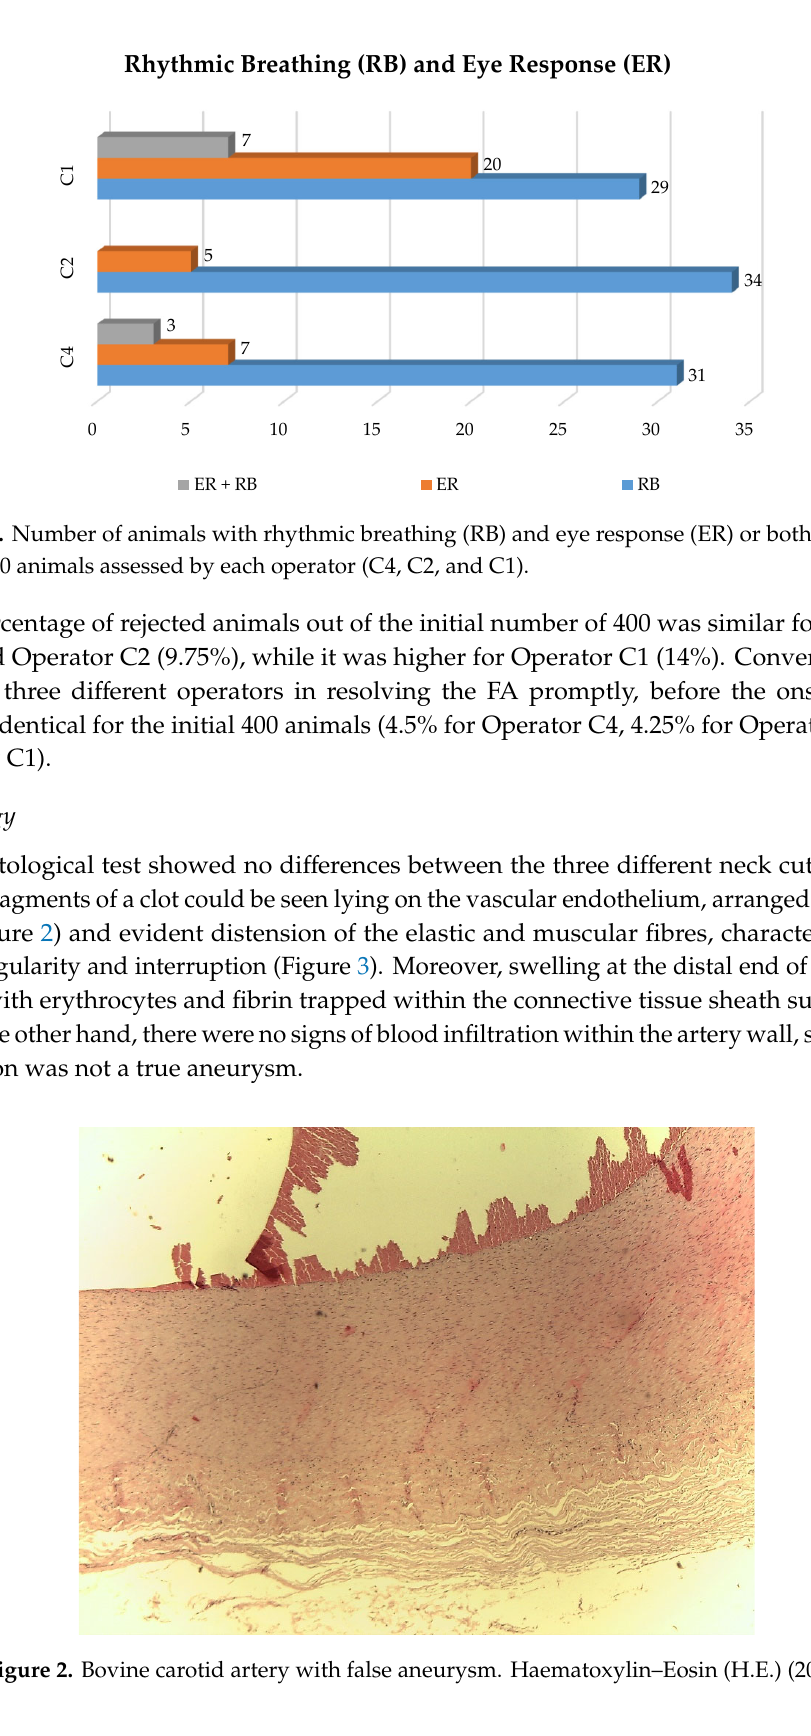
Figure 3. Bovine carotid artery with false aneurysm. Mallory ʹ s trichrome (40×). 4. Discussion The results need to be interpreted with caution because our study was limited by several factors. First of all, we used information provided by the slaughterhouse and we were not involved in the data collection. The slaughterhouse reports did not specify some aspects such as the exact time of false aneurysms or the onset of reflexes, as well as the exact number of the slaughtered animals belonging to the two breeds and the days when the slaughters took place. Consequently, our data cannot be used to compare the activity of the three operators in terms of quality, but only of quantity. Secondly, the onset of false aneurysms may have been influenced by the operators because, even though the three operators had attended the same training course and worked for the same amount of time in that slaughterhouse, their cut may be affected by each one’s manual skills. In a future study, it would be more appropriate to consider a single operator who makes cuts at different points along the neck in order to totally eliminate the variability linked to the operator. Another limit of our study is its failure to compare Halal and traditional slaughtering in order to verify the importance of stunning in preventing the onset of false aneurysms and reflexes and, consequently, in safeguarding